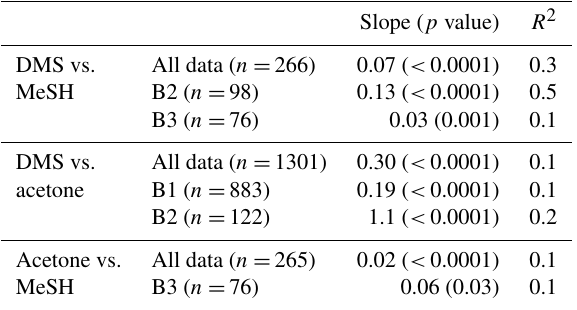
Table 3. Pearson correlations between DMS a , MeSH a and acetone a , which are significant at the 95% confidence interval. Land-influenced data were removed